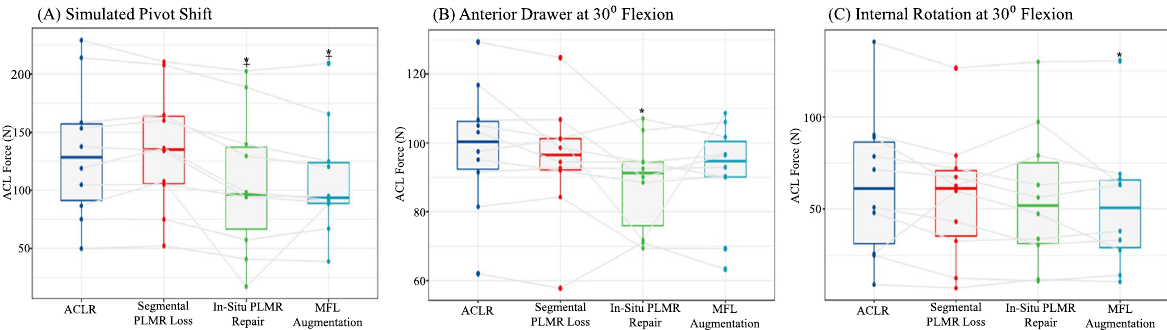
Fig. 3 Box plot graphs demonstrating median force in newtons for ( A ) the simulated pivot shift, ( B ) the anterior drawer at 30° flexion and ( C ) the internal rotation at 30° flexion tests. Dots represent individual specimen observations. Thick horizontal lines represent group medians, while top and bottom of boxes represent the 25 th and 75 th percentiles, respectively. *: Significantly different from ACLR, Meniscus